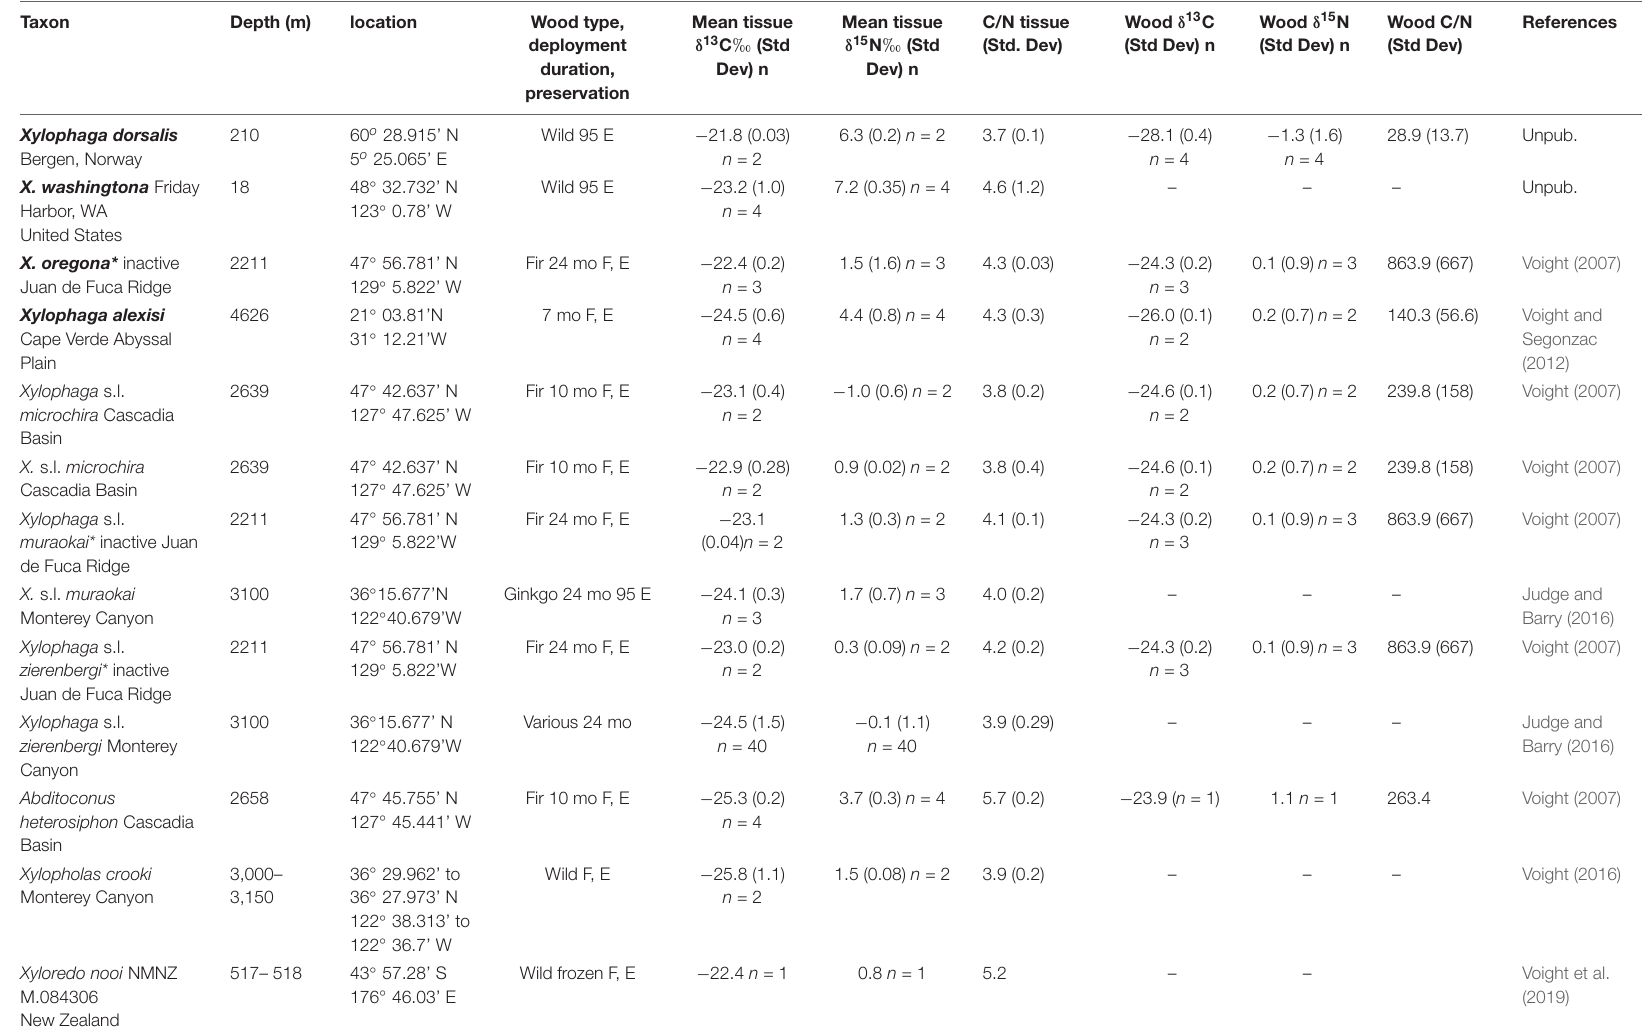
TABLE 1 | The taxon, depth, locality, wood type, deployment duration (if applicable), preservation (F, E formalin to ethanol; 95 E 95% ethanol), mean tissue δ 13 C value (standard deviation) and number of specimens, mean tissue δ 15 N value (standard deviation) and number of specimens, mean tissue C/N ratio (standard deviation), mean wood δ 13 C value (standard deviation), mean wood δ 15 N value (Standard deviation), wood C/N ratio (standard deviation) and the source of these